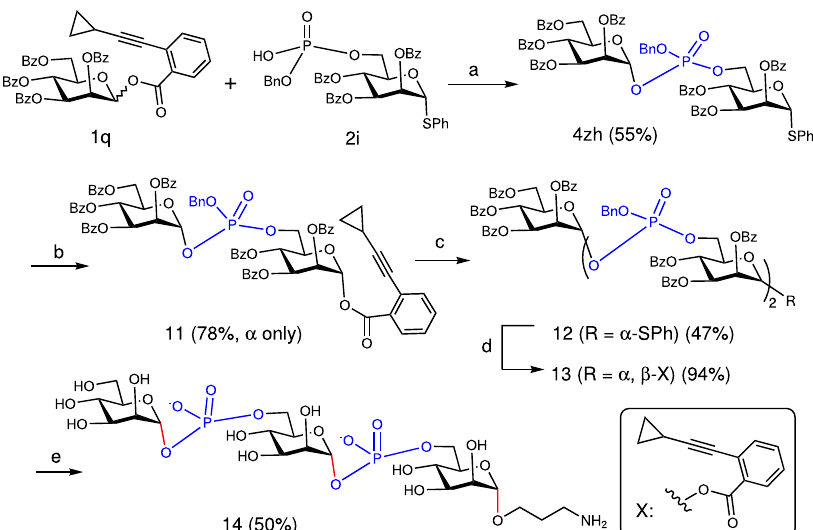
Fig. 8 The synthetic route to GPS 14 via iterative elongation. a Ph 3 PAuNTf 2 (10 mol%), 5 Å MS, DCE. b 1) NBS, acetone, H 2 O; 2) HX, EDCl, DMAP, CH 2 Cl 2 . c 2i , Ph 3 PAuNTf 2 , DCE. d 1) NBS, acetone, H 2 O; 2) HX, EDCl, DMAP, CH 2 Cl 2. e 1) 3-azidopropanol, Ph 3 PAuNTf 2 (10 mol%); 2) H 2 , Pd/C, HCOOH, HCOONH